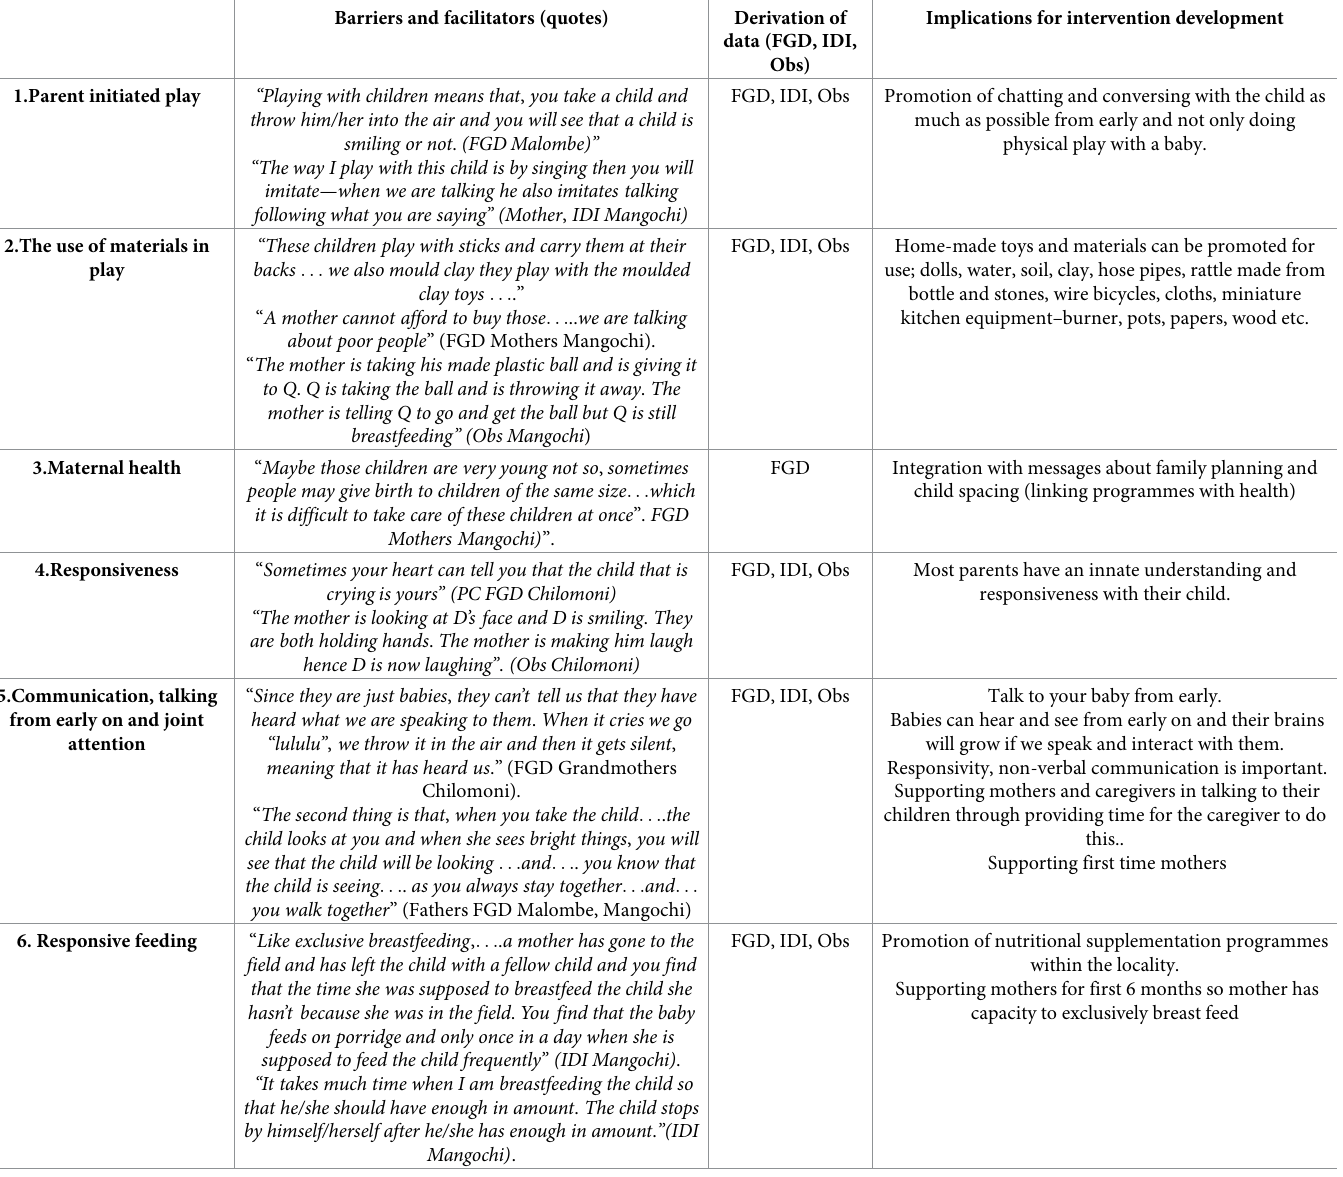
Table 4. Barriers and enablers to care, responsiveness, play and stimulation at the level of the parent-carer dyad. Barriers and facilitators